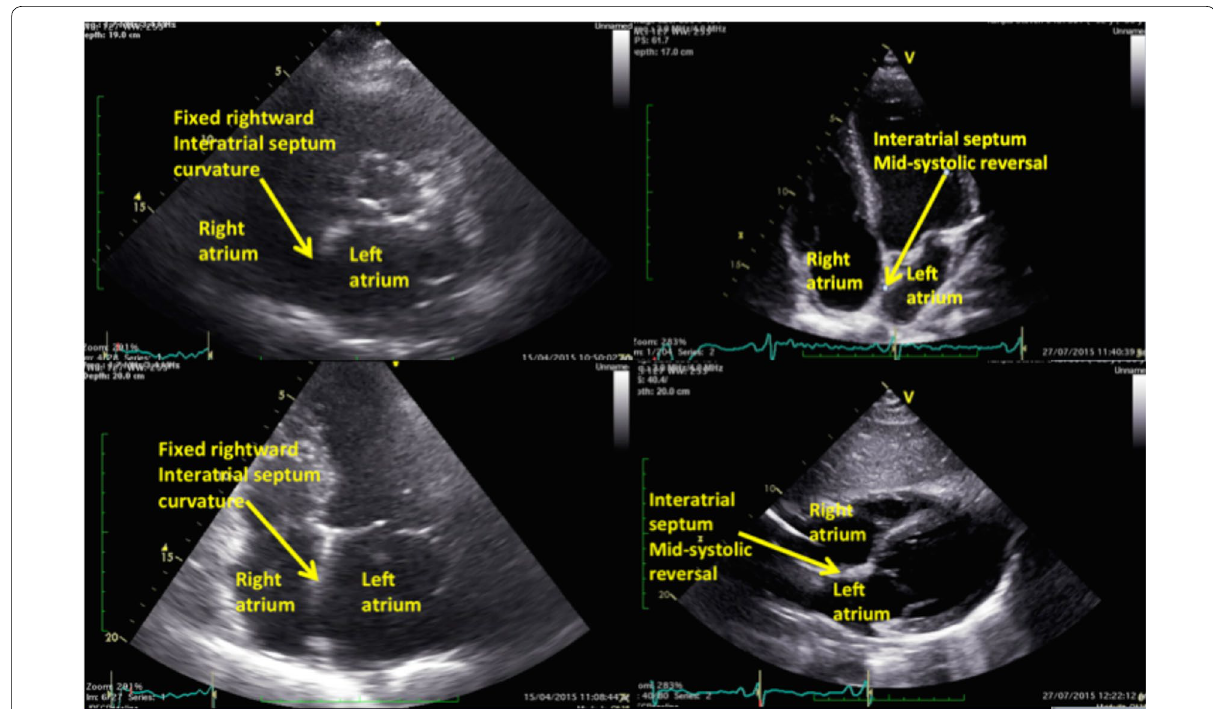
Fig. 4 Interatrial septal movements during the cardiac cycle. Fixed rightward interatrial septum curvature is bowing of the interatrial septal to right throughout the cardiac cycle, and mid-systolic reversal is reversal of the septum from right to left during mid-systole